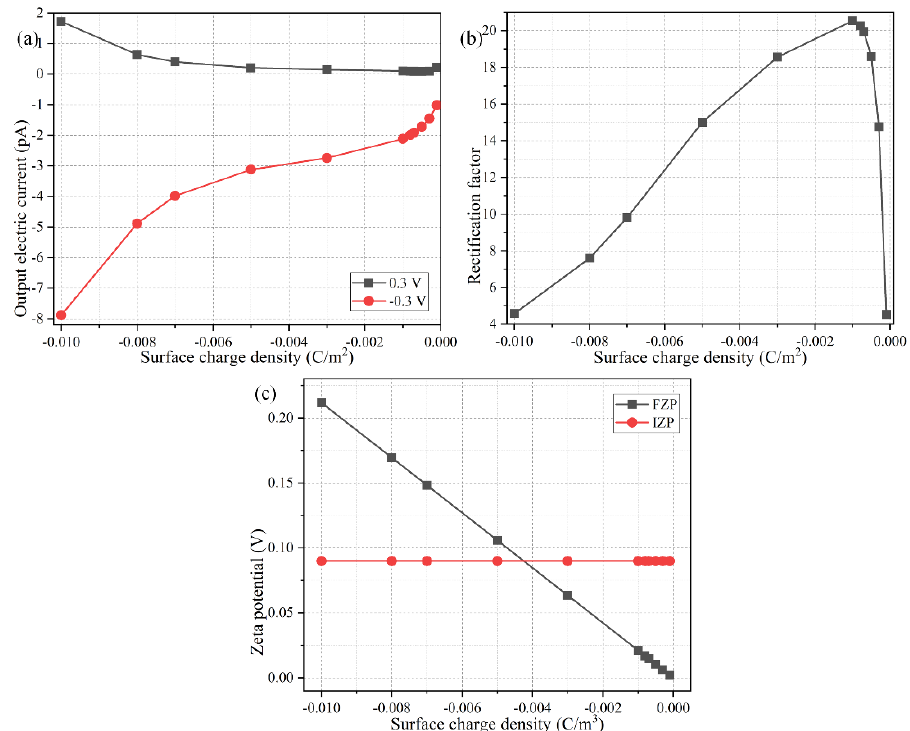
Figure 5. Effect of the native surface charge density of a negatively-charged dielectric wall on the device rectification performance, under a given parametric space of R N = 15 nm, L C = 600 nm, V S = 0.3 V, and c 0 = 0.1 mM. ( a ) The forward and backward output electric current, and ( b ) the rectification factor, and ( c ) approximation of the zeta potential magnitude, as a function of the surface charge density.